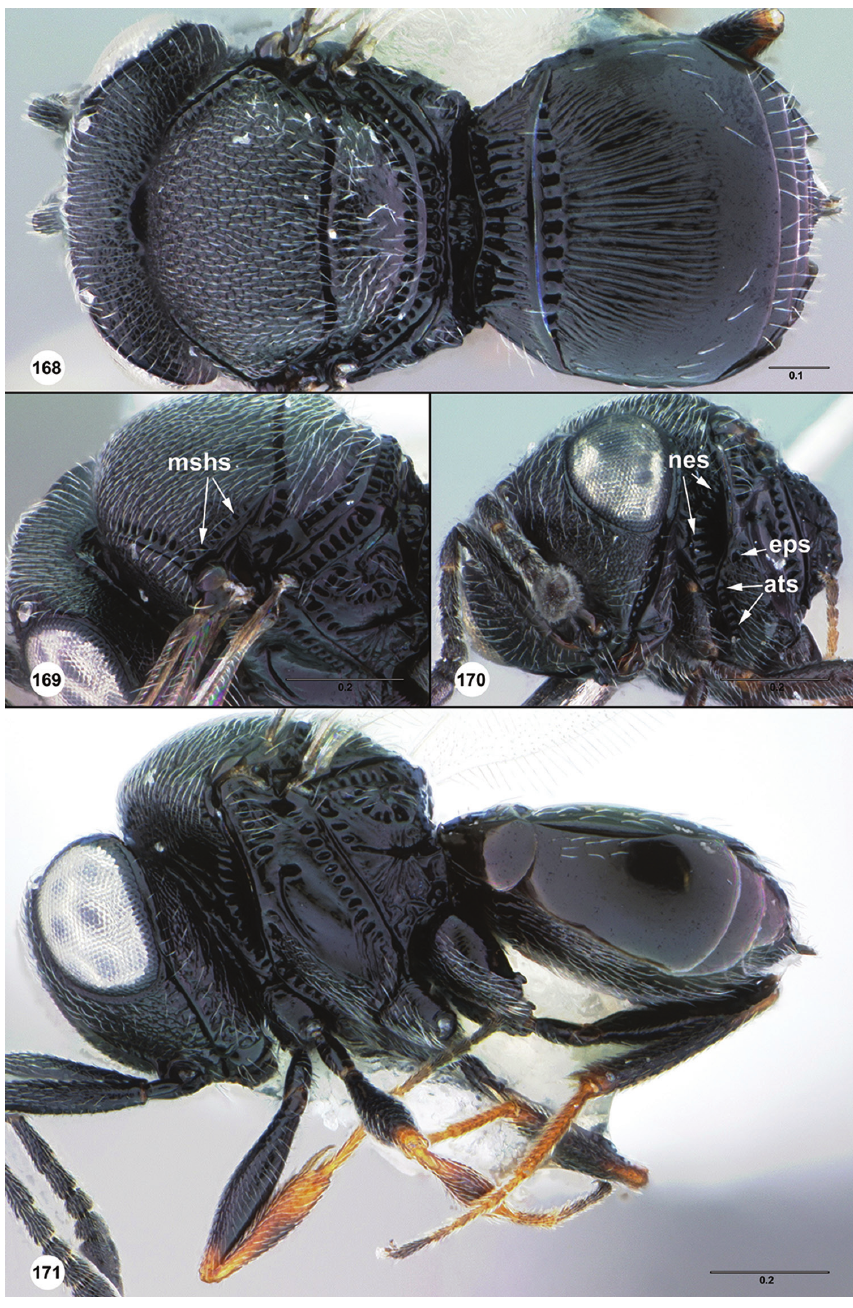
Figures 168–171. T. semistriatus 168 female (USNMENT01109059), head, mesosoma, metasoma, dorsal view 169 female (USNMENT01109059), head and mesosoma, dorsolateral view 170 female neo- type (NHMW 0007A), head and mesosoma, anteroventral view 171 female (USNMENT01109059), head, mesosoma, metasoma, lateral view. Scale bars in